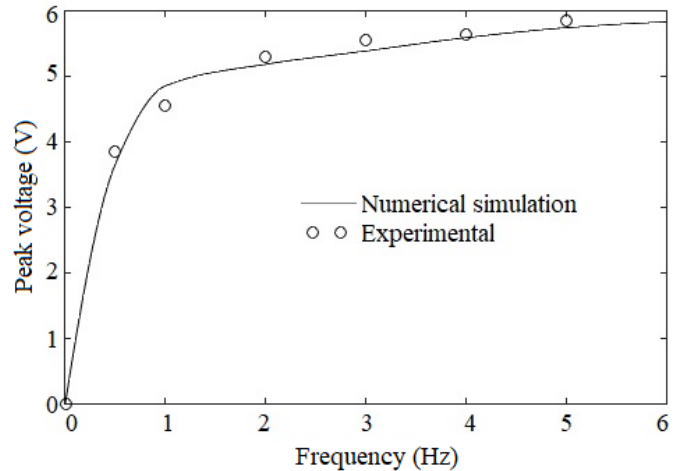
Figure 14. Variation of peak voltage with frequency.